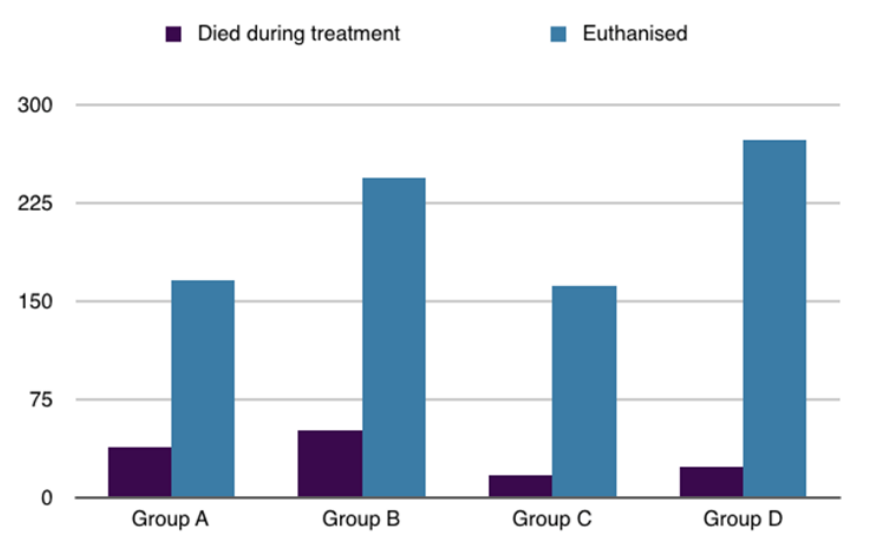
Figure 1: % survival for paediatric patients who received veterinary treatment. Group A canine patients ≤3 months of age; group B canine patients 3-6 months of age; Group C feline patients ≤3 months of age; Group D feline patients 3-6 months of age.